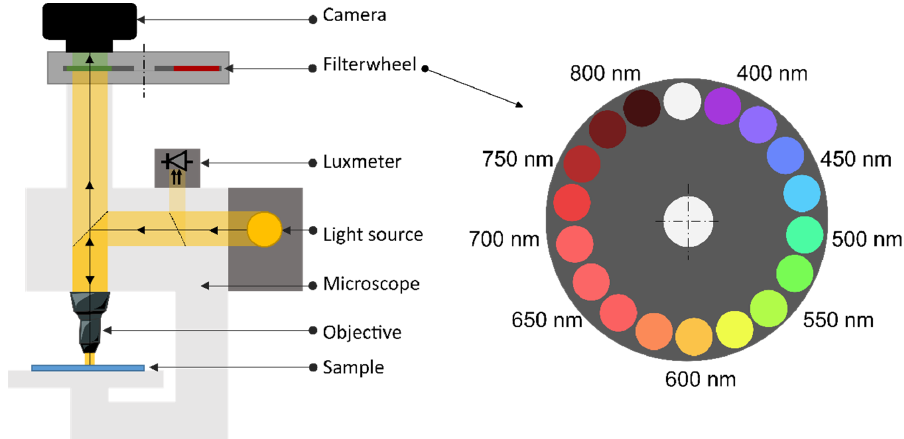
Figure 3. Scheme of the setup. (Imaging optics inside the microscope are not displayed). The setup is composed of a microscope Zeiss Axio Imager M1 m mounted with the objective EC Epiplan Neofluar 5×/0.13 HD DIC. The light source is a Zeiss HAL 100 tung- sten-halogen lamp set at 3200 K; it was turned on at least 20 minutes before the experi- ments to reach the steady state. Its emission spectrum is stronger for large wavelengths than for small wavelengths. To remove the specular reflections on the sample, a polarizer and an analyzer are used in a crossed configuration inside the microscope. A luxmeter, Yocto-Light-V3 LIGHTMK3 from Yoctopuce, is inserted across the path of the incident light beam in order to calibrate the irradiance of the sample for each image capture. The photodiode, manufactured by Rhoms (reference BH1751FVI), can measure in the range of 0 to 100,000 lux with a resolution of 0.25 lux. The camera is a commercial reflex camera, Canon 1200D with a RGGB CMOS sensor. The ISO was set to 800. The sensor, coded in 14 bits, has a resolution of 3516 × 5344 pixels. The camera is remotely monitored by a com- puter through a Python program. The filterwheel is composed of 17 filters (Hard Coated OD 4.0 25 nm Bandpass Filters from Edmund Optics) and driven by a motor. The camera captures at least one picture per filter with an adapted exposure time. The central wave- lengths of the filters are in the range [400; 800 nm] with a 25 nm step. The filters have a 25 nm bandwidth. In practice, 13 filters are used in the range [400; 700 nm] corresponding to the spectral bandwidth of the light source. To retrieve the spatial and spectral reflectances of a sample from the pixel values obtained through the camera, the apparatus is calibrated as follows. One pixel value is related to reflectance through [24–27]: 𝑉 = 𝑇𝑒 (cid:3505)𝐸(𝜆) (cid:3090)